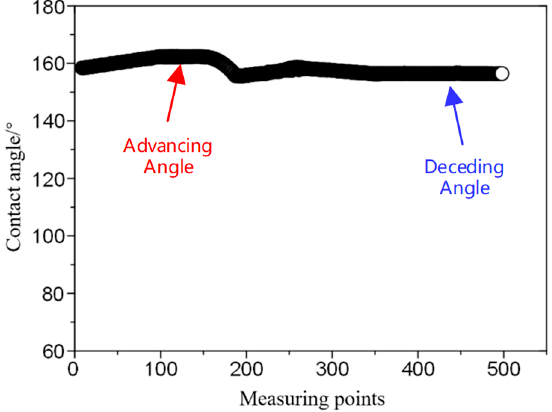
Figure 2. Water contact angle hysteresis of the super-hydrophobic methyl silicone resin/SiO 2 composite surface.